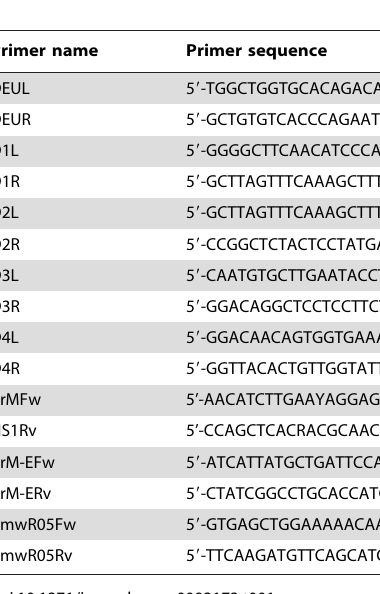
Table 1. List of primers used in the